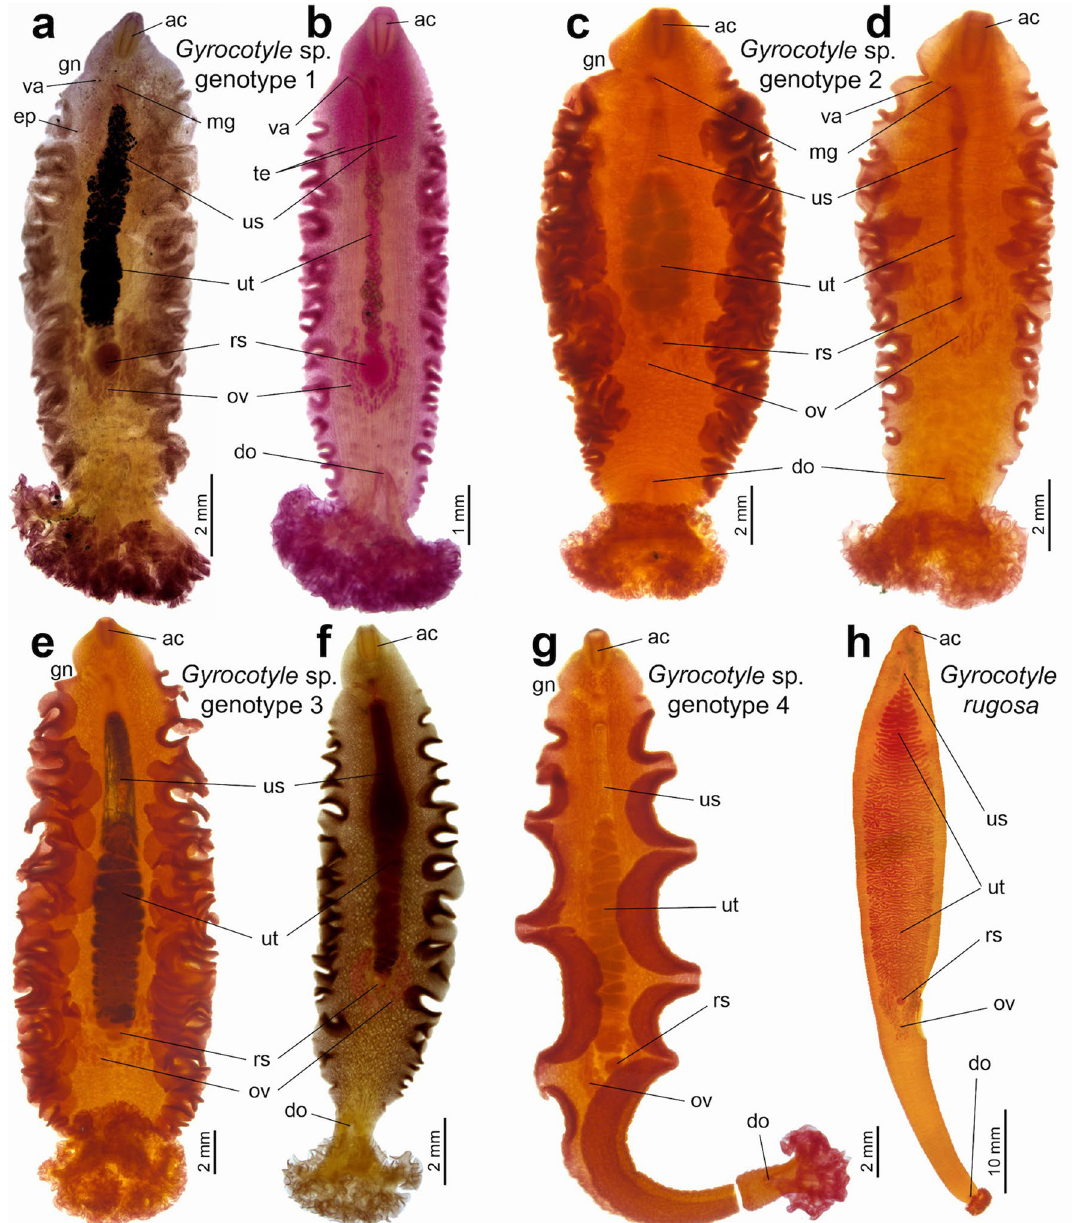
Figure 2. Whole mounts of Gyrocotyle spp. off Taiwan and Argentina. Morphological vouchers of Gyrocotyle sp. genotype 1 ex Chimaera phantasma ( a ), specimen TW212-1*; ( b ), specimen TW13-1, Gyrocotyle sp. genotype 2 ex Chimaera cf. argiloba ( c ), specimen TW138*; ( d ), specimen TW139*, Gyrocotyle sp. genotype 3 ex C. cf. argiloba ( e ), specimen TW215* and C. phantasma ( f ), specimen TW10-1, Gyrocotyle sp. genotype 4 ex C. cf. argiloba ( g ), specimen TW141*, all from Taiwan; and Gyrocotyle rugosa ex Callorhinchus callorynchus Argentina ( h ), specimen AR89*. Field numbers with asterisks above indicate the hologenophores. ac acetabulum, do dorsal opening, ep excretory pore, gn genital notch, mg male gonopore, ov ovary, rs receptaculum seminis, te testes, us uterine sac, ut uterus, va is U-shaped, the uterus coiled, and its distal part forms a well-developed uterine sac containing unembryonated eggs. Two excretory pores open posterolateral to the uterine pore (Figs. 2a ‒ f, 3a ‒ d). However, these three genotypes can be distinguished from each other by the unique combination of morpho- logical traits (Supplementary Table S2). Specimens of Gyrocotyle sp. genotype 1 possess a large acetabulum and a rosette of the same width or wider than the maximum body width. The acetabular spines are less numerous, and the dorsal body spines are small and distributed mostly on the posterior half of the body, whereas ventral spines are few and restricted to near the rosette. The testicular field reaches one-fourth of the uterus length, the ejaculatory duct is straight, and the uterine sac is middle-sized (Fig. 2a,b).